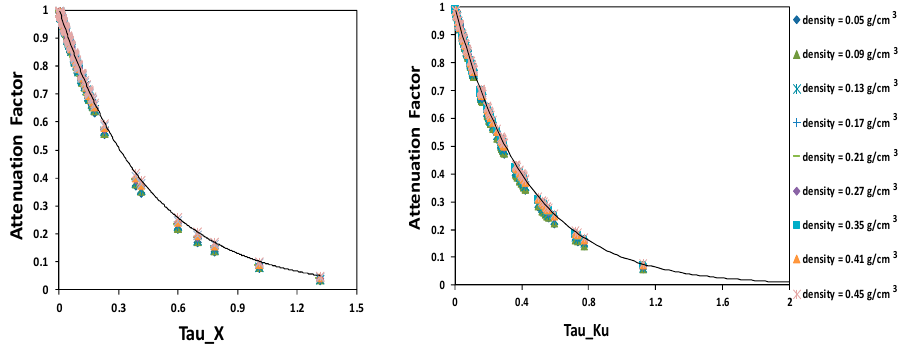
Figure 3. The attenuation factor for different snow densities for X ( left ) and Ku ( right ) bands.